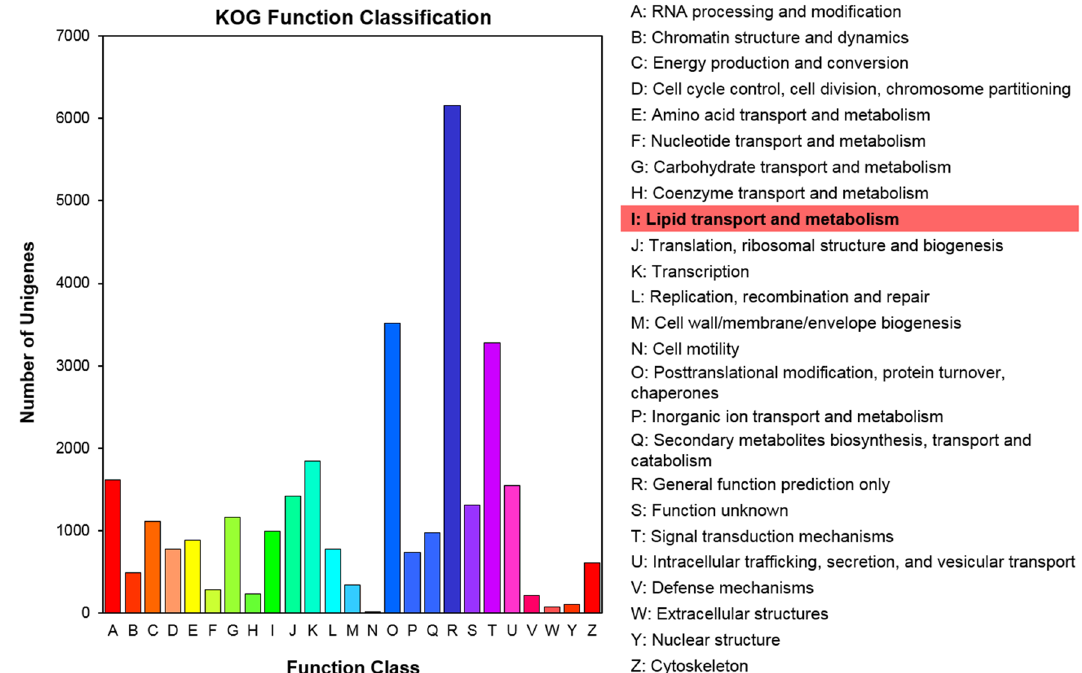
Figure 4. EuKaryotic Ortholog Group (KOG) functional classification for the transcriptome sequences of sacha inchi unigenes classified into 25 KOG categories (listed as A to Z in the key on the right of the figure). The y-axis indicates the number of unigenes in each KOG category.